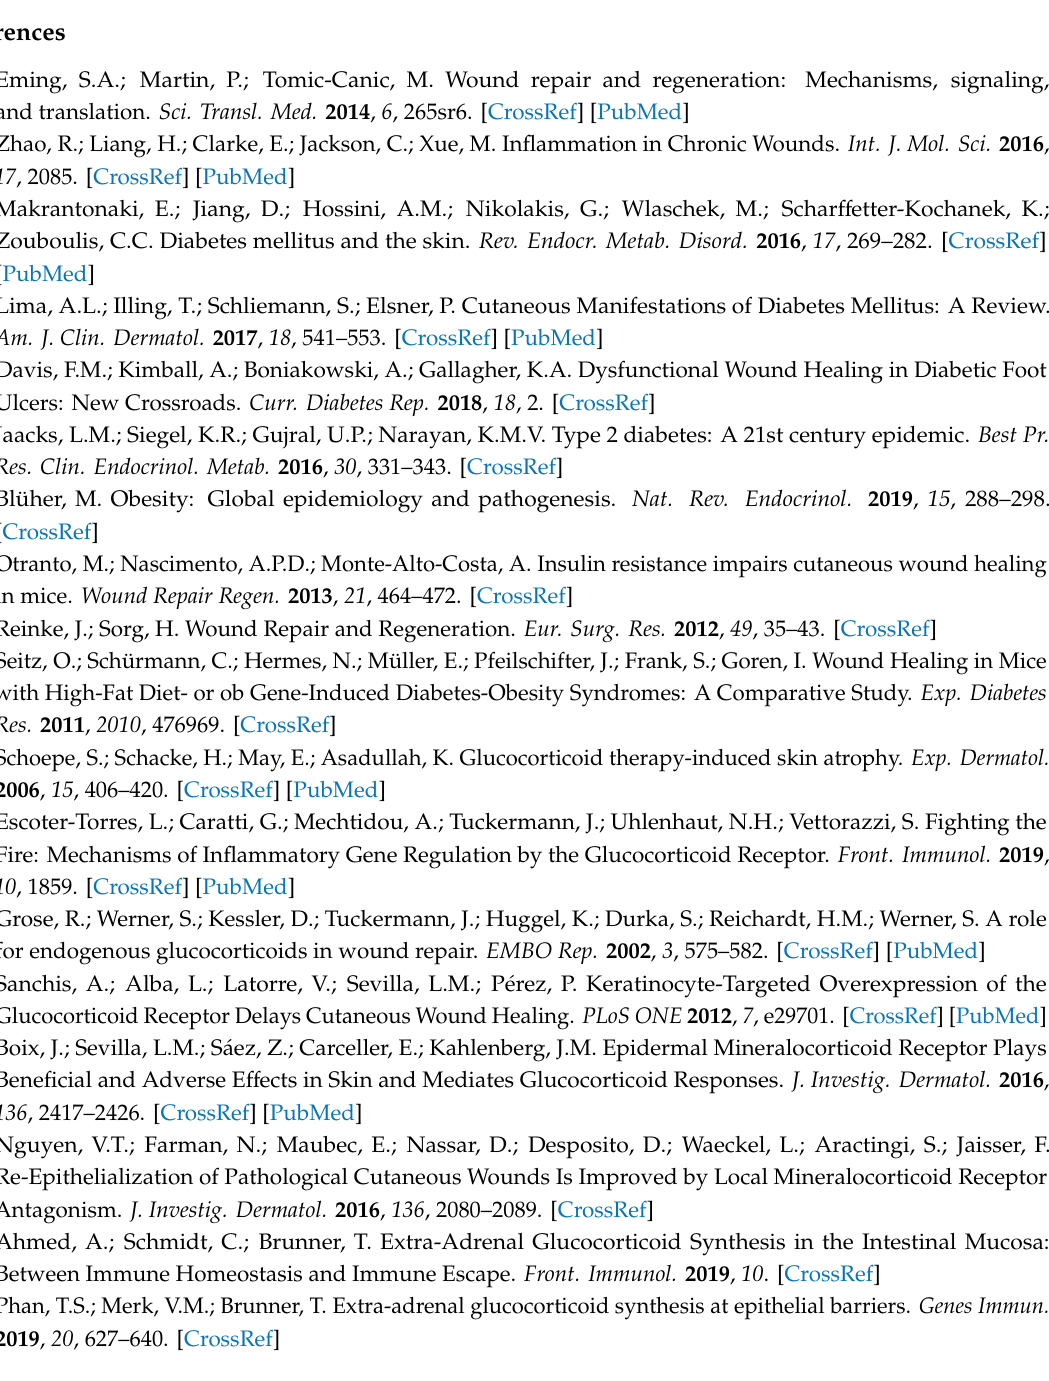
Table S1: Primers; Table S2: Antibodies; Figure S1: Insulin down-regulates 11 β -HSD1 expression in